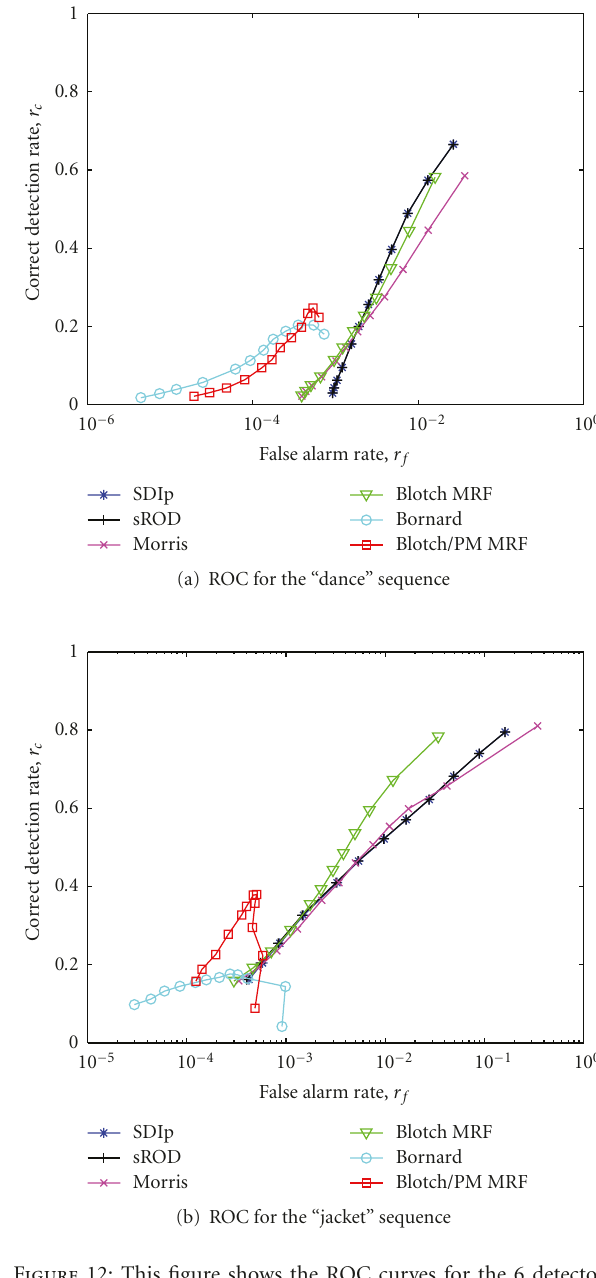
Figure 12: This figure shows the ROC curves for the 6 detectors under test for each test sequence. The standard parameter set is used for the proposed algorithm. The set up of each detector is described in Section